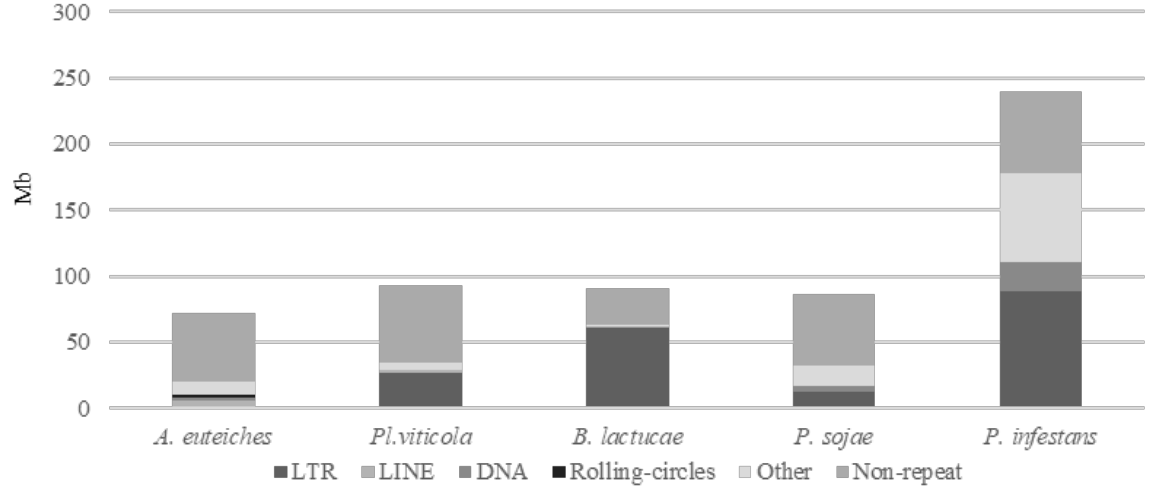
Figure 2. Repeats and non-repeated sequence distribution in plant pathogenic oomycete genomes as compared to A. euteiches . Three plant pathogenic oomycetes ( Plasmopara viticola, Bremia lactucae, Phytopthora sojae ) sequenced with long-read technology and the P. infestans genome were used to compare repeats and non-repeated sequences’ distribution within the legume pathogen A. euteiches ATCC201684. Families of repeats are indicated with a grey color. Data are available in ST1c-d. The large proportion of repeated regions in the A. euteiches genome prompted us to look for putative tandemly repeated sequences varying in size, copy number and sequence conservation, which could correspond to putative satellite DNA. The latter was recently reported following genome resequencing by long-read technology of the oomycete Phytoph- thora parasitica [37]. Based on the report by Panabi è res et al. [37], we searched for tandemly repeated sequences with monomer sizes ranging from 100 to 500 bp. The monomeric sequences were used to perform BlastN searches against the A. euteiches genome to identify the number of occurrences in the genome; the ones with more than 100 occurrences were kept for further analysis. We used blastclust pairwise comparison to group the tandem repeats into clusters based on sequence similarity. Our analysis revealed 41 families (AeSat) of tandem repeats matching satellite DNA criteria (Table S1e). As previously described for Phytophthora , the GC content might vary significantly between satellite DNA families, from 39% to 63% for the A. euteiches genome. The number of copies varied from 106 to more than 3000 for the four most-represented AeSat (i.e., AeSat1–AeSat4). In these regions, no coding sequences were identified, but for ten AeSat, we identified similarities with known transpos- able elements (TE), such as DNA/Harbinger, DNA/Helitron, NonLTR/Tad1, LTR/Gypsy and IntegratedVirus/DNAV (Table S1e). Sequence homologs of the two abundant families PpSat1 and PpSat2 from P. parasitica [37] were identified in A. euteiches . To unravel the relationship among satellite DNA families, a phylogenetic tree was constructed including PpSat1 and PpSat2 from P. parasitica [37] (Figure 3). The topology of the tree suggests diversification in AeSat families, with high copy number (i.e., >1000) families clustered into a central location